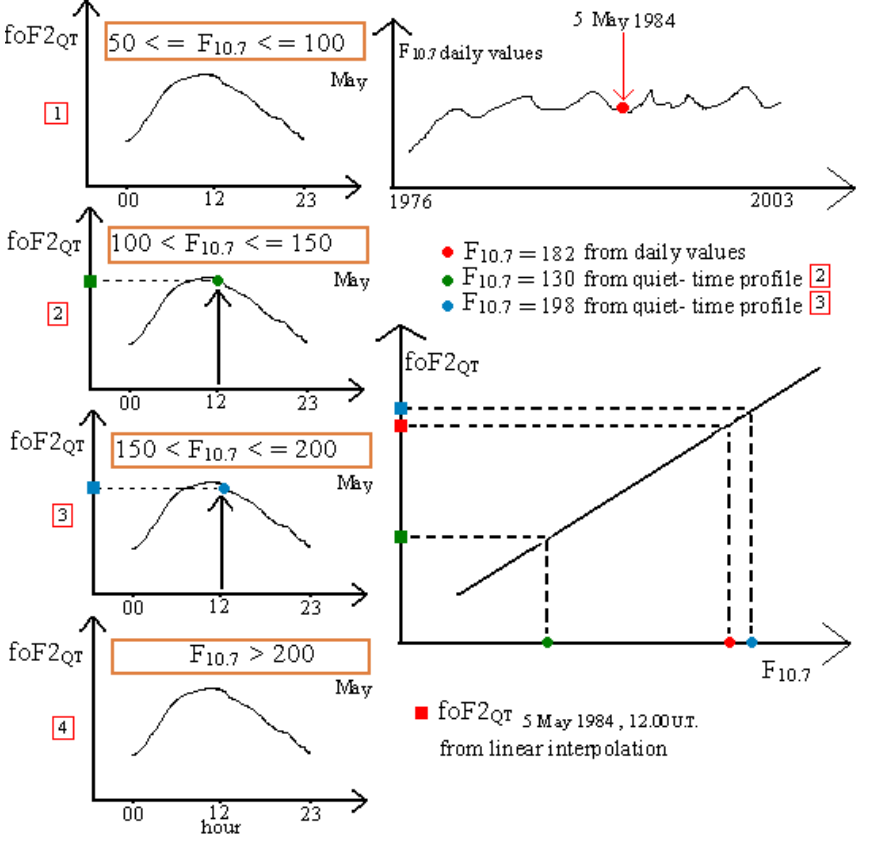
Fig. 4. An example of the procedure followed to calculate the quiet-time value of fo F2 for a given day (5 May 1984) and hour (12:00 UT).